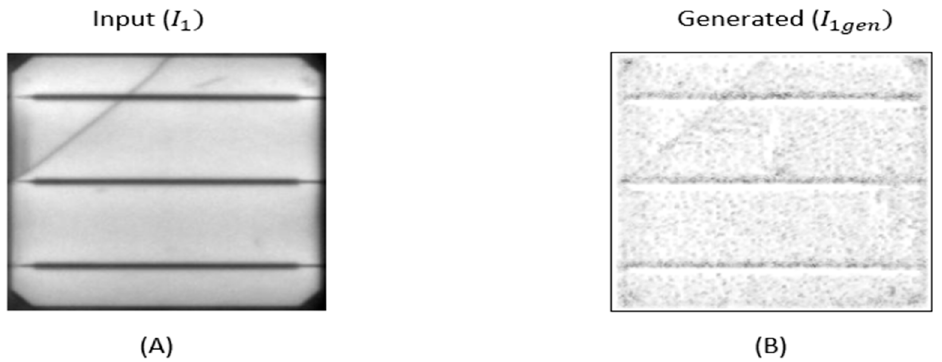
Figure 8. FIA output ( A ) input ( B ) resultant PV